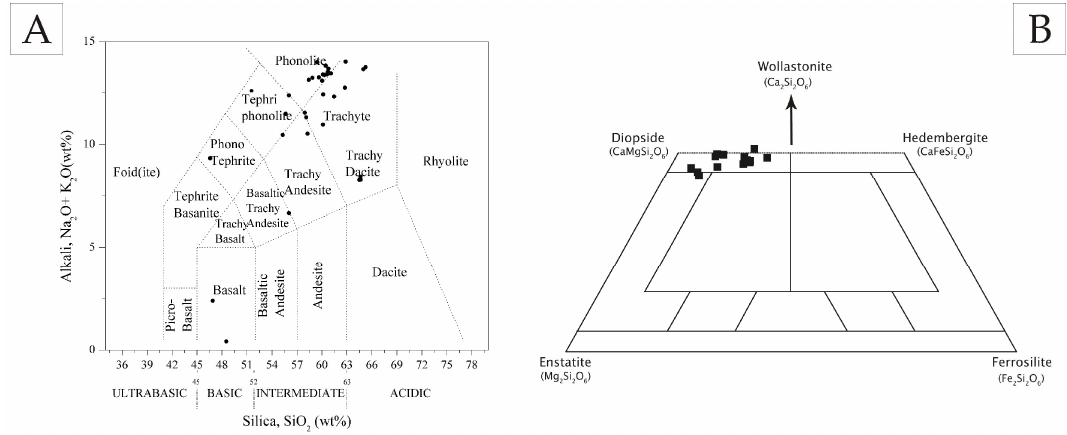
Figure 7. ( A ) Plot of scoriae / pumice composition into the total alkali silica (TAS) diagram [22]; ( B ) Plot Figure 7 . ( A ) Plot of scoriae/pumice composition into the total alkali silica (TAS) diagram [22]; ( B ) Plot of Cpx composition into the classification diagram for Ca–Mg–Fe pyroxenes of Cpx composition into the classification diagram for Ca–Mg–Fe pyroxenes [23].